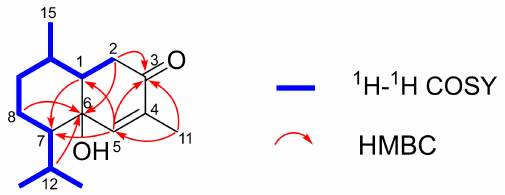
Figure 2. Key 1 H- 1 H COSY and HMBC correlations of 1